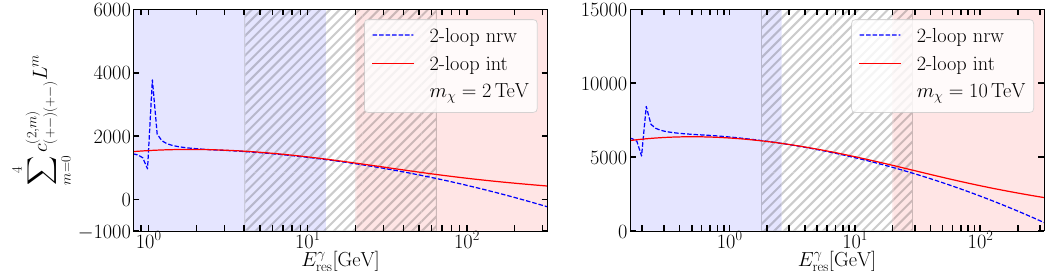
Figure 8 . Two-loop coefficient of the series (5.3) (including all logarithms and evaluated on the central scales) for the ‘nrw’ (solid) and ‘int’ (dashed) factorization formulas. Left: m χ =2 TeV. Right: m χ =10 TeV.